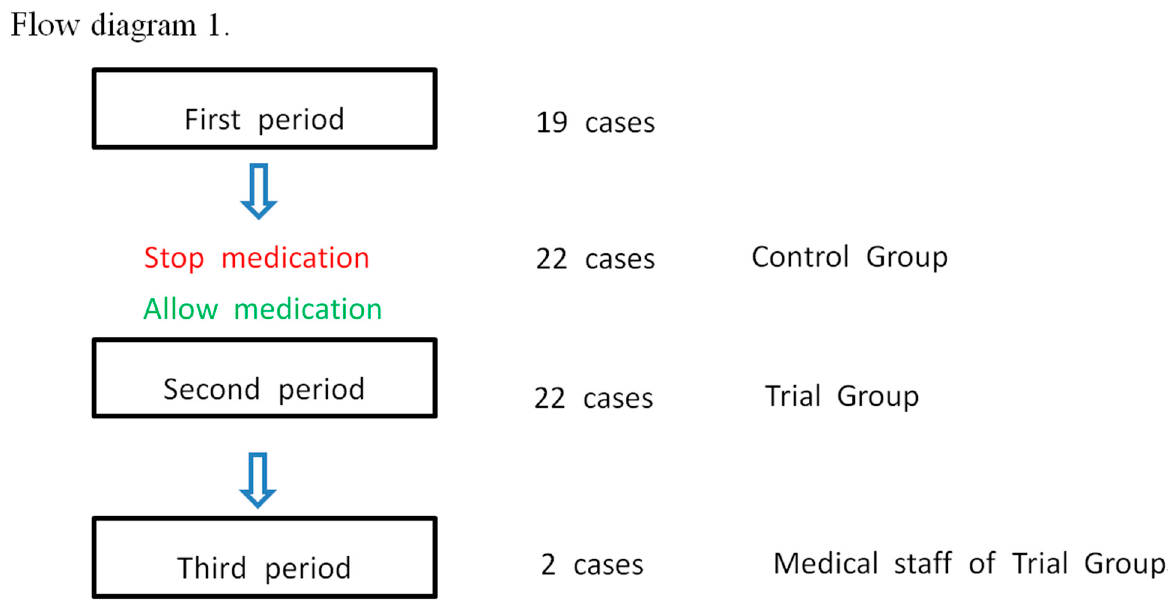
Figure 4. Flow diagram for cross-sectional study. An off-label medication was administered in 19 cases, and a control group (22 cases) and a trial group (22 cases) were observed [14].